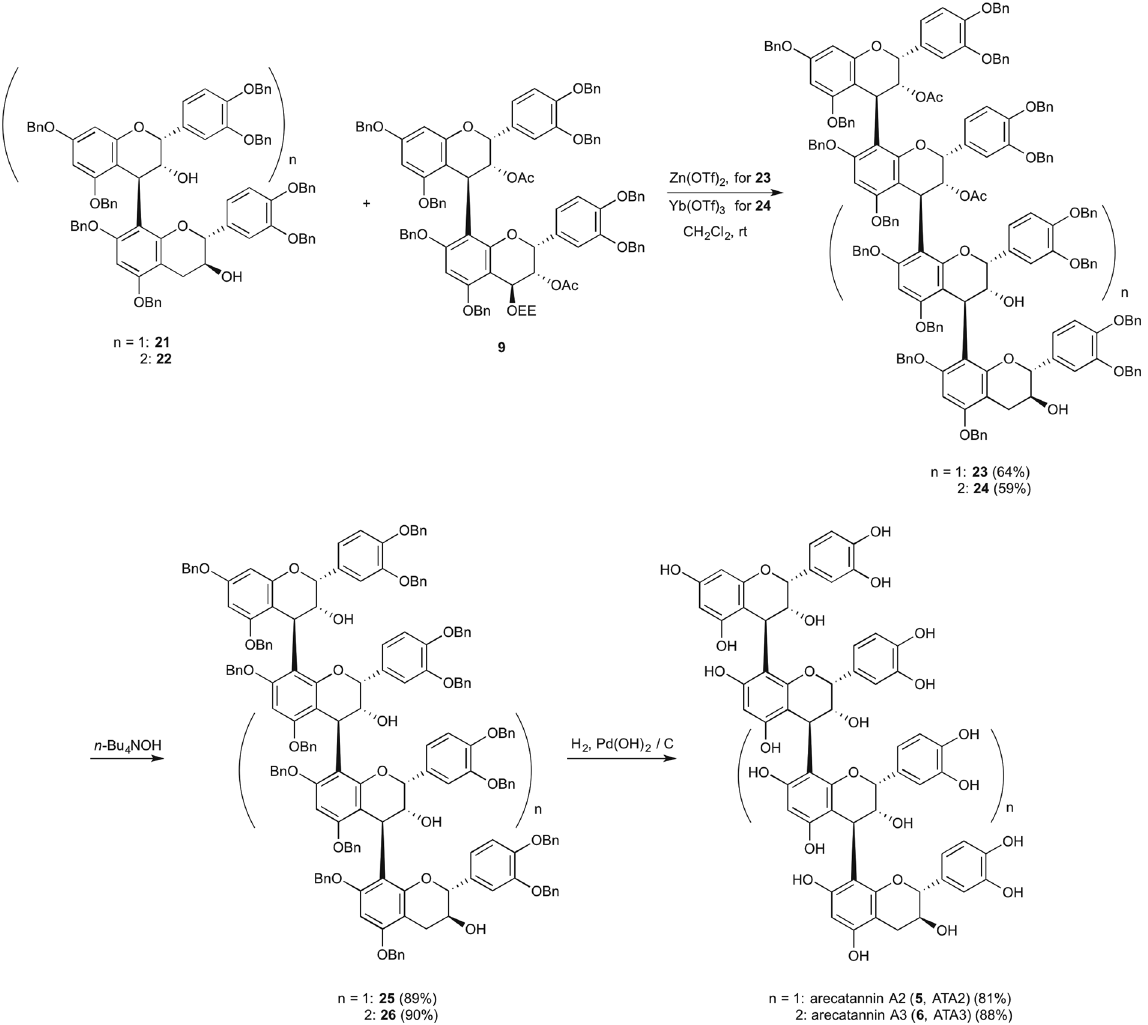
Figure 4. Synthesis of arecatannin A2 ( 5 , ATA2) and A3 ( 6 , ATA3). Arecatannin A2 ( 5 , ATA2) and A3 ( 6 , ATA3) were synthesized using Zn(OTf) 2 and Yb(OTf) 3 mediated equimolar condensation. Yb(OTf) 3 , ytterbium